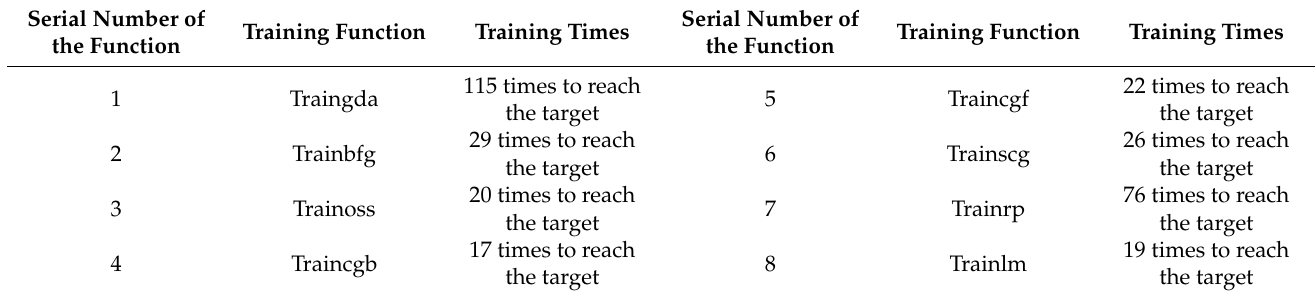
Table 8. Selection of training